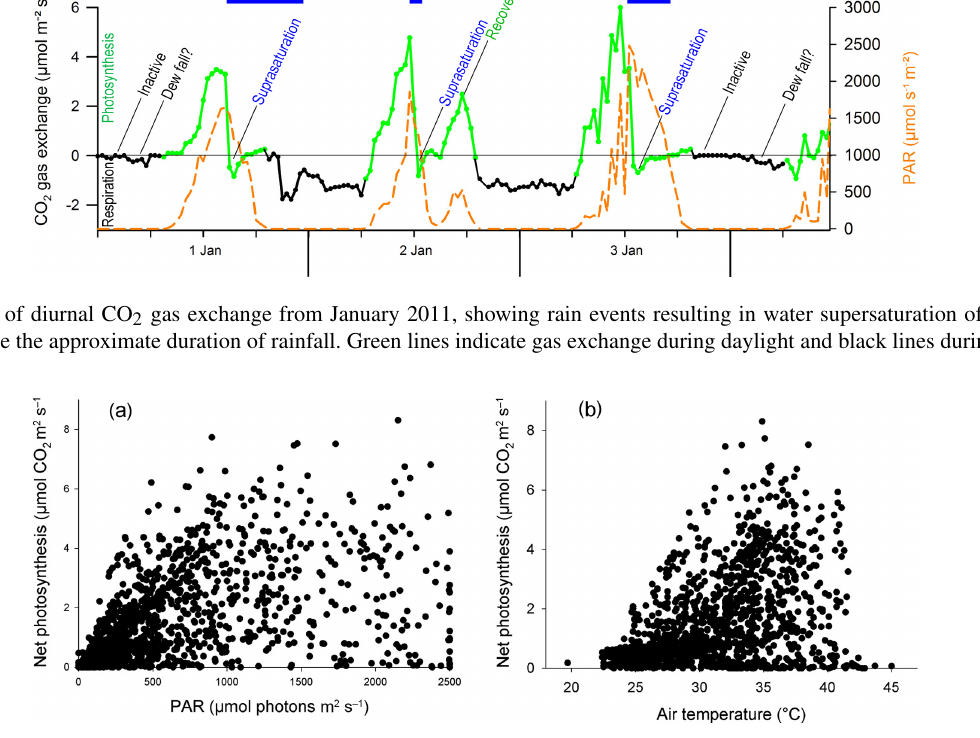
Figure 6. (a) Net photosynthesis from all days related to light intensity (PAR). The biocrust shows a saturation at 2200µmolphotonm 2 s − 1 and a slight depression at 2400µmolphotonsm 2 s − 1 and greater. (b) Net photosynthesis from all days related to air temperature. The optimum temperature is at 35 ◦ C but the biocrust still performs very well at 42 ◦